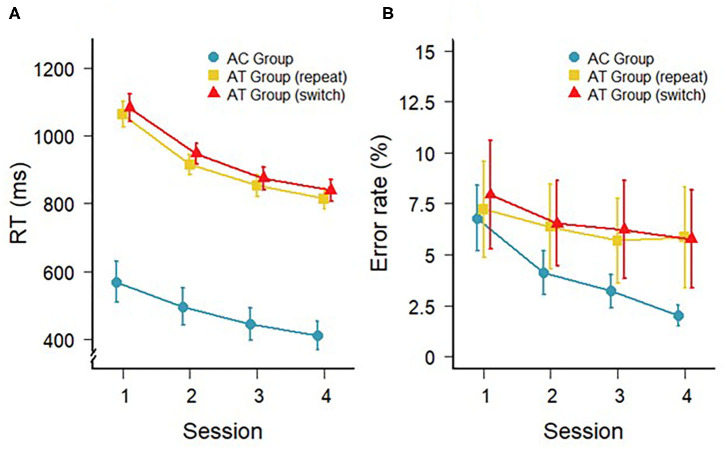
(A) Mean RTs (in ms) and (B) mean error rates on repeat and switch trials during task-switching training of the AT group and during the single task training of the AC group (repeat trials only). Error bars depict standard errors of the mean.